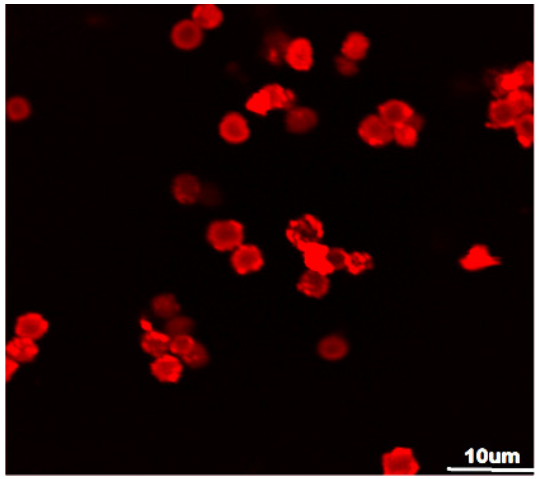
Fig. 4. CLSM images of AuNR-HM-DOX microcapsules with red °uorescence DOX loaded in the